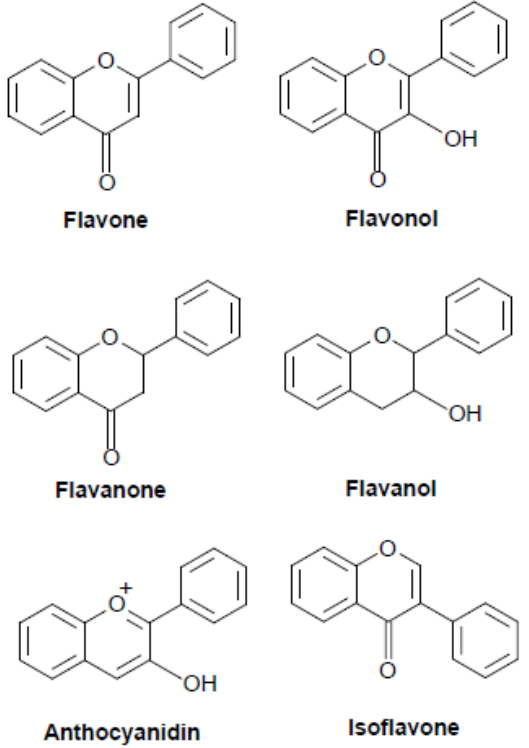
Figure 1. Structure of the major classes of flavonoids.